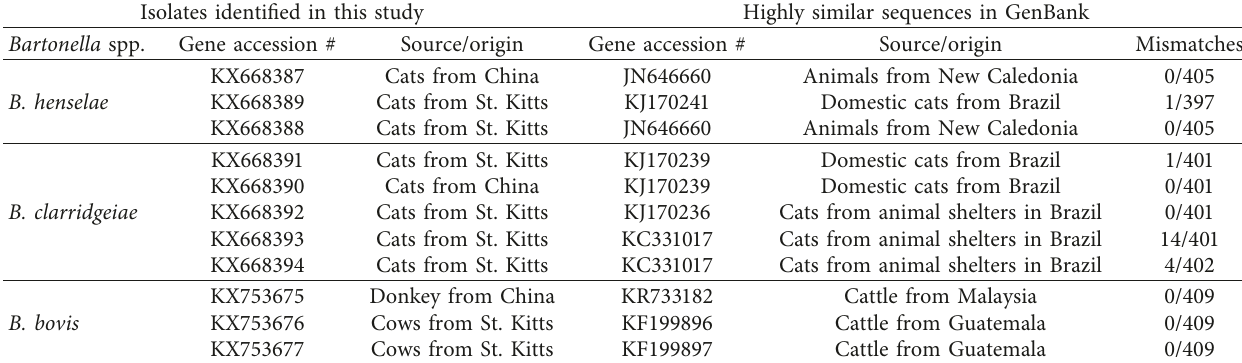
Table 2: Comparison of isolates identified in this study and similar sequences in GenBank by BLAST. Isolates identified in this study Highly similar sequences in GenBank Bartonella